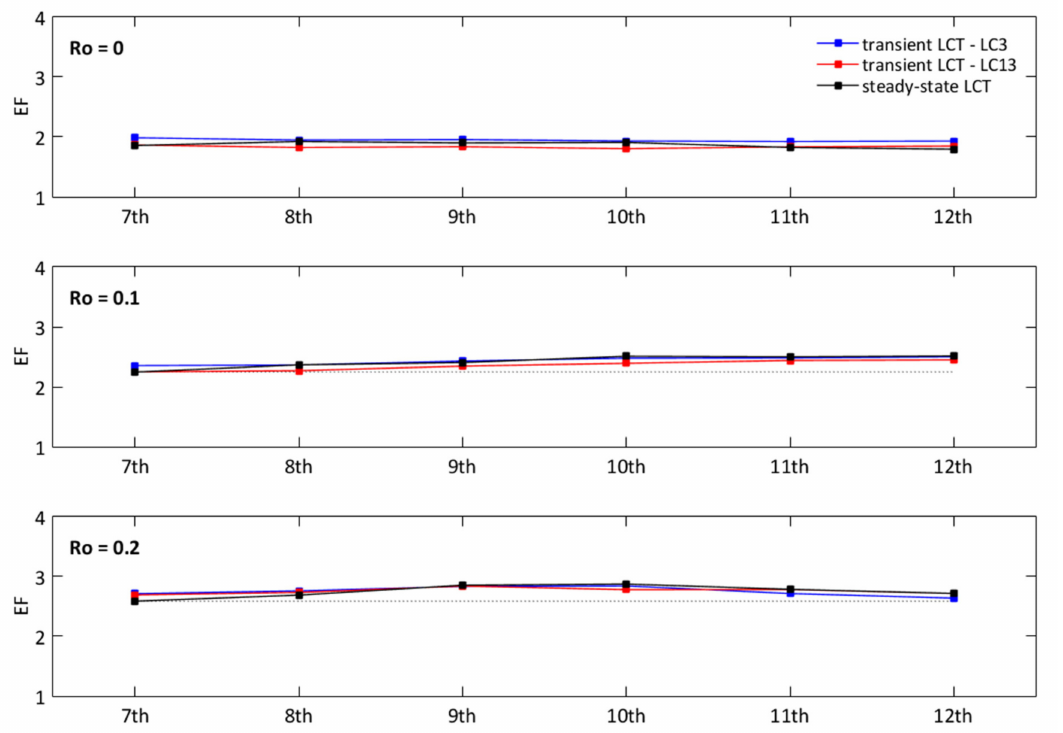
Figure 14. Averaged enhancement factor on inter-rib